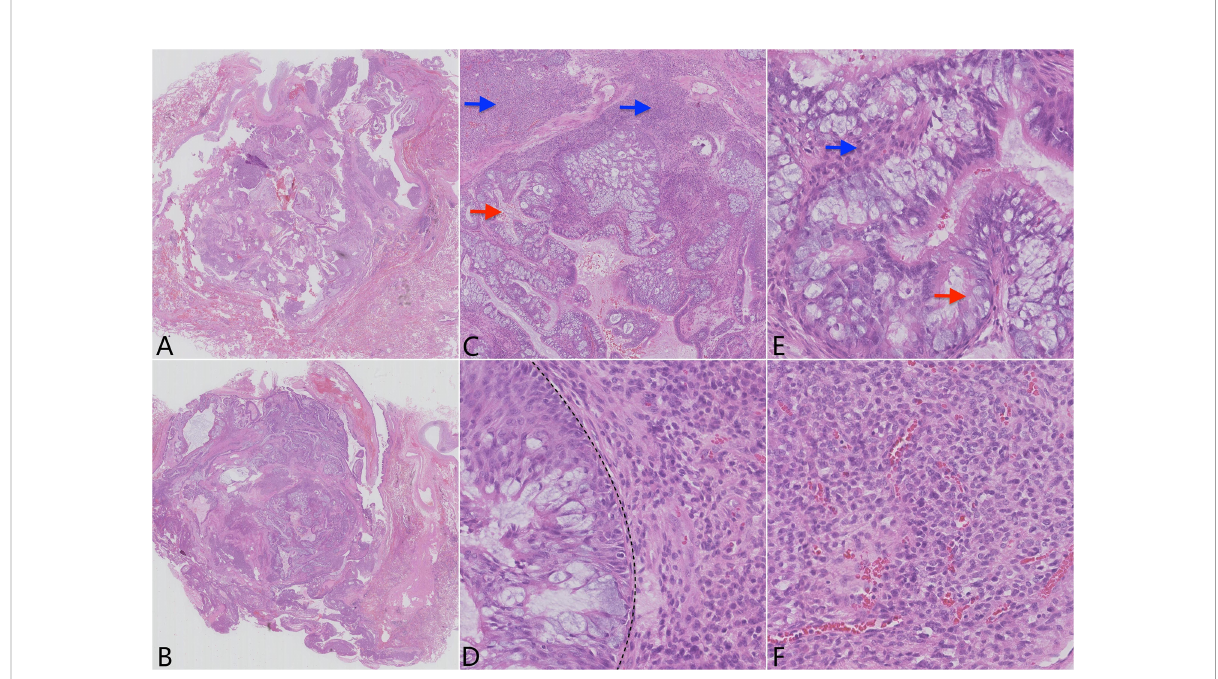
FIGURE 2 Pathological fi ndings of the tumor show two distinct histological subtypes. (A) H&E of the whole slide scan showing the well-de fi ned tumor located in the dilated bronchus or bronchiole and (B) focally connecting to the normal bronchial walls. (C) Lower power H&E (×4) reveals two distinctly demarcated tumor cell populations (red arrow: epithelial component; blue arrow: mesenchymal component). (D) High power H&E (×40) reveals that the two components grow closely to each other, but without a transitional zone (line). (E) H&E (×40) of the mixed squamous cell and glandular papilloma (red arrow: glandular component; blue arrow: squamous cell component). (F) H&E (×40) of the glomus tumor